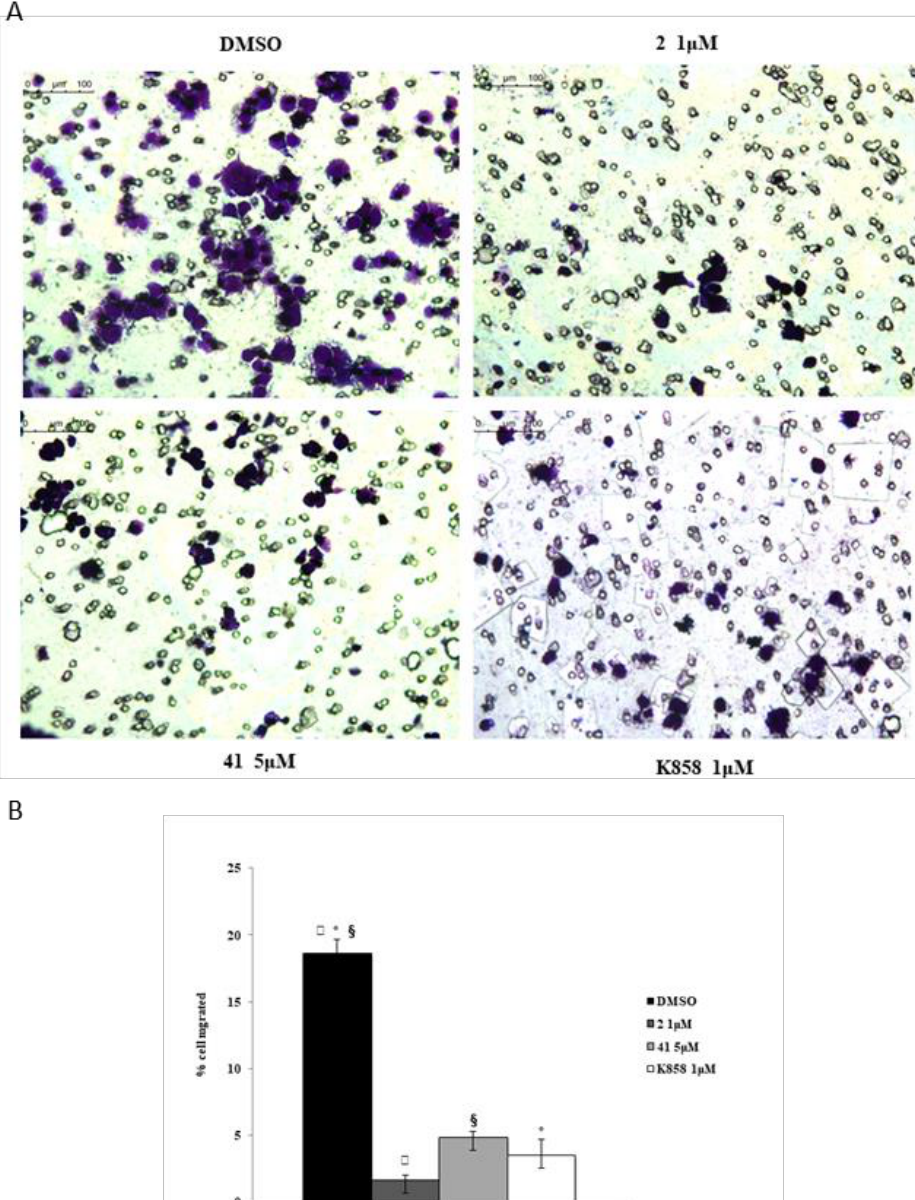
Figure 8. Transwell migration assay in AGS cell line in the presence of compounds 2 , 41 and K858 . Dose treatments are 1 µ M for compound 2 and K858 , and 5 µ M for compound 41 , respectively. ( A ) Images represent migrated cells after staining with crystal violet. ( B ) Histogram represents densitometric analysis determined by quantifying thresholded area for violet color in 10 fields for each of three slides per sample. Data are presented as mean ± standard deviation. * K858 1 µ M vs.